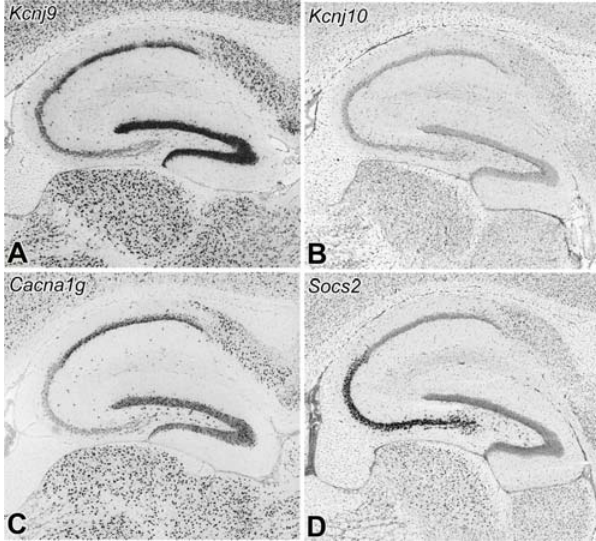
Figure 8. Expression patterns of seizure related genes with cis - and trans -QTLs in Qrr1p . Candidate gene Kcnj9 (A) has heavy expression in neurons. Kcnj9 shows a regionally restricted expression in the hippocampus with intense labeling in dentate gyrus, strong labeling in CA1, and relatively weak labeling in CA2 and CA3. Candidate gene Kcnj10 (B) has a more diffused pattern and expressed primarily in glial cells. There is almost no labeling for Kcnj10 in the hippocampus. Transcripts of seizure-related genes, Cacna1g (C) and Socs2 (D), have trans-QTLs in Qrr1p . Both genes show high expression in neurons. Cacna1g matches the expression of Kcnj9 with strong labeling in dentate gyrus and CA1, and weak labeling in CA2 and CA3. Socs2 complements the expression of Kcnj9 and Cacna1g with intense labeling in CA2 and CA3. In Situ expression data are from the Allen Brain